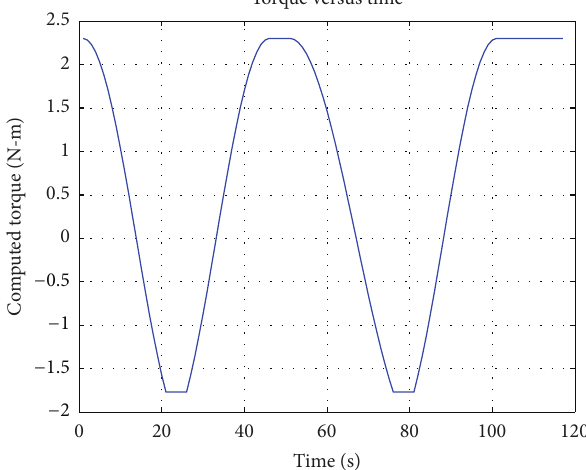
Figure 23: Joint torque graph at elbow due to elbow flexion and